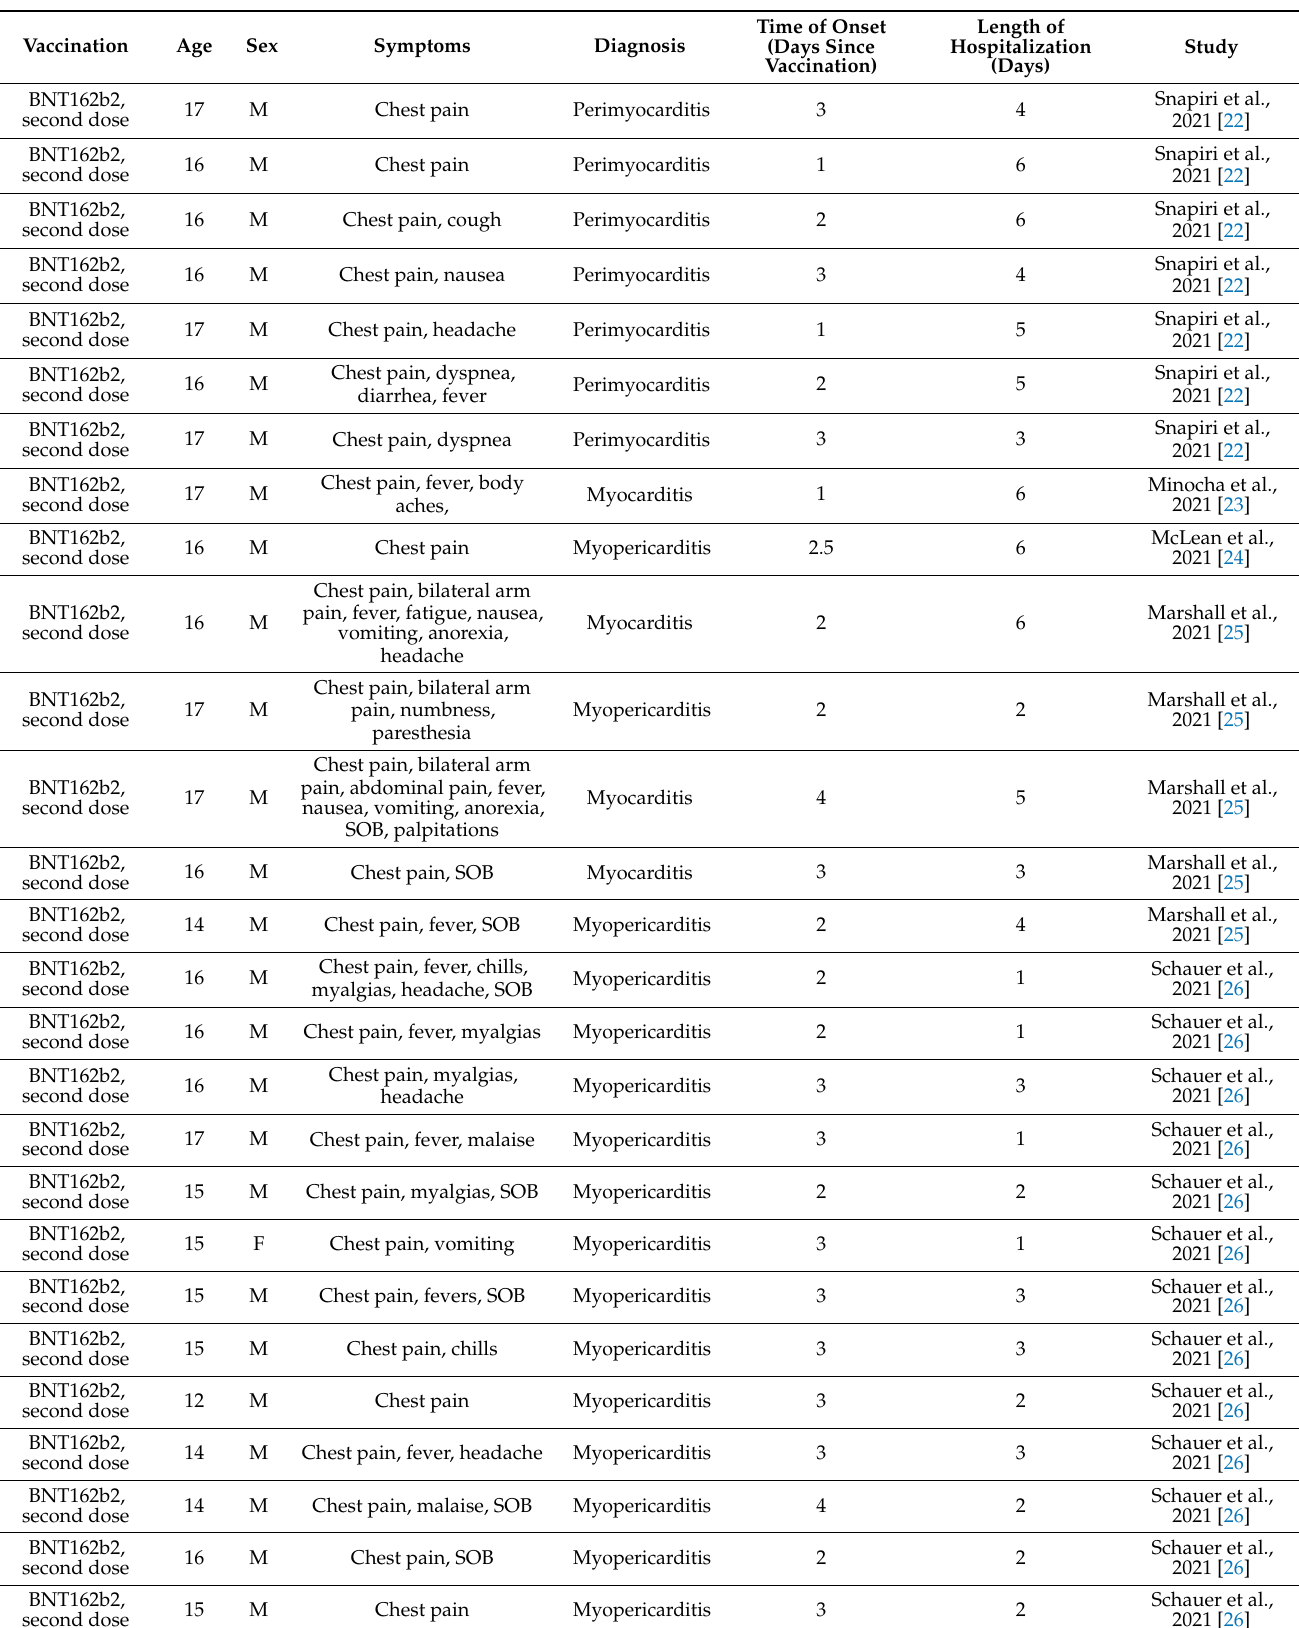
Table 3. Basic information of diagnosed myocarditis and/or pericarditis cases (n =